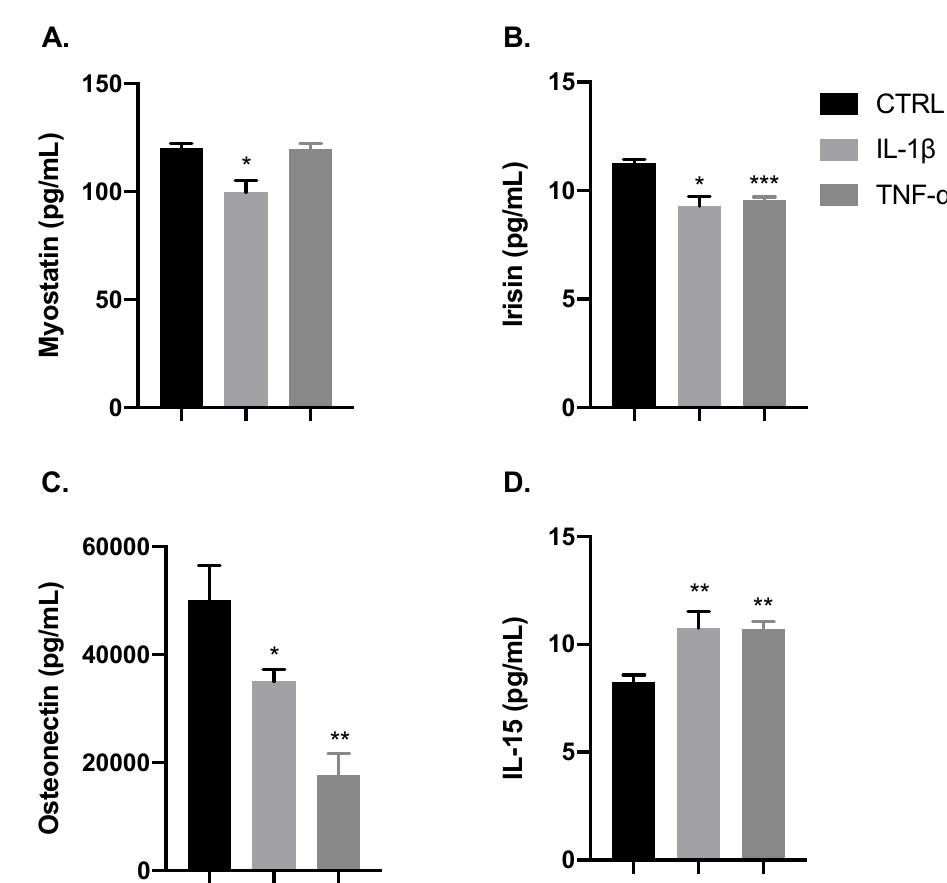
Figure 6. IL-1 β and TNF- α modulate myokines release. Bar charts illustrate the release of myokines ( A ) Myostatin, ( B ) Irisin, ( C ) Osteonectin, and ( D ) IL-15. Both IL-1 β (gray) and TNF- α (dark gray) reduced the release of osteonectin and irisin, and they increased the release of IL-15 in comparison with control (black). Release of myostatin was not affected by TNF- α . Data are shown as mean ± SEM (* p < 0.05, ** p < 0.01, *** p < 0.001 vs. control from unpaired t -test).